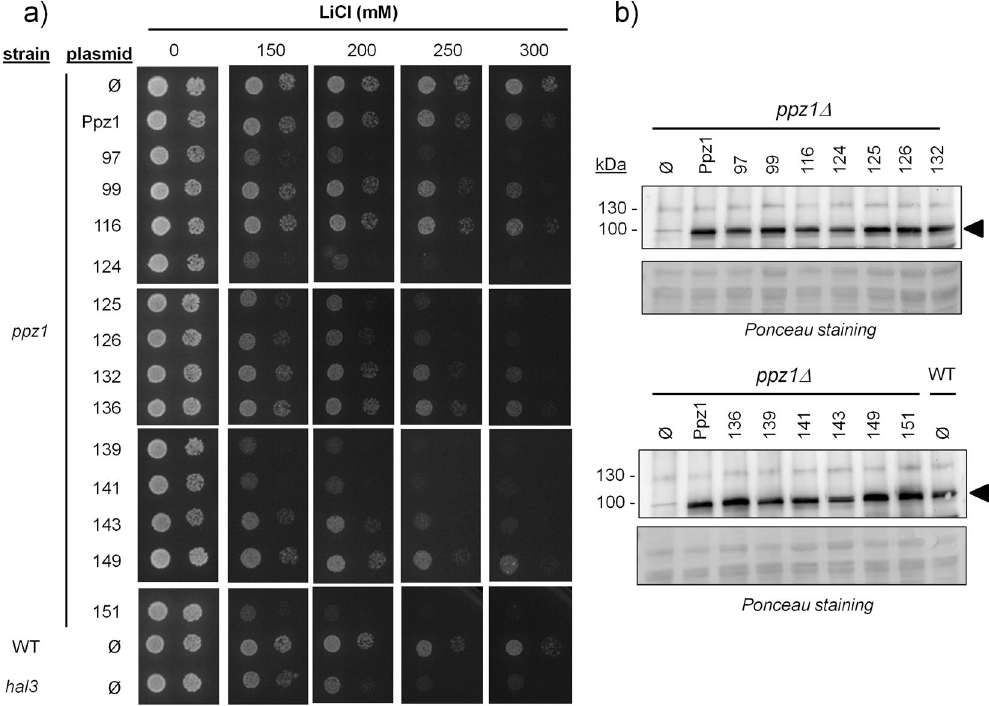
Figure 2. Tolerance to Li + cations conferred by the diverse variants of the Ppz1 phosphatase. ( a ) The indicated strains were transformed with the diverse versions of Ppz1, and cultures were spotted as in Fig. 1 and grown for 72 h in the presence of various concentrations of LiCl. ( b ) Protein extracts (40 μ g) from the indicated strains were subjected to electrophoresis on 10% polyacrylamide-SDS gels. Proteins were transferred to membranes and probed with a polyclonal anti-GST-Ppz1 antibody. Ø, empty plasmid; WT, wild